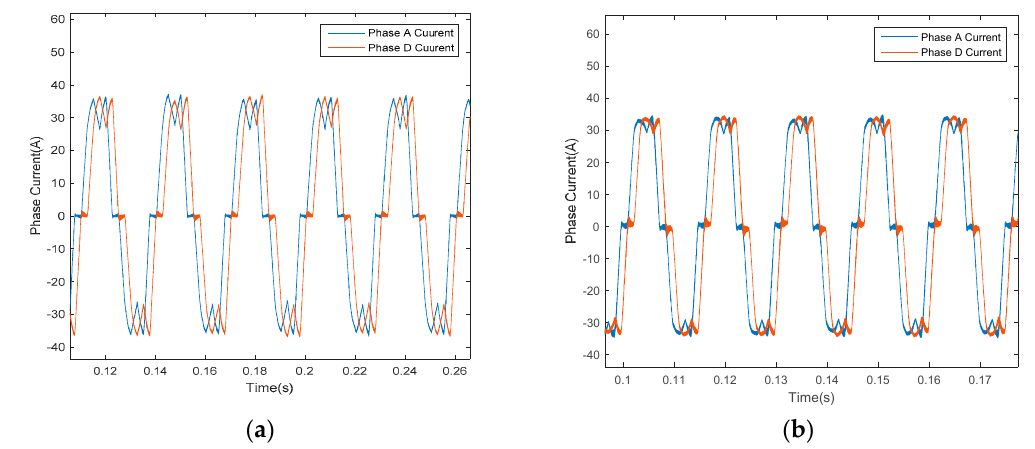
Figure 13. Phase A and D currents without adopting voltage compensation and resonant controller in the x-y subspace, (a) speed is maintained at 500 rpm and (b) speed is maintained at 1000 rpm.